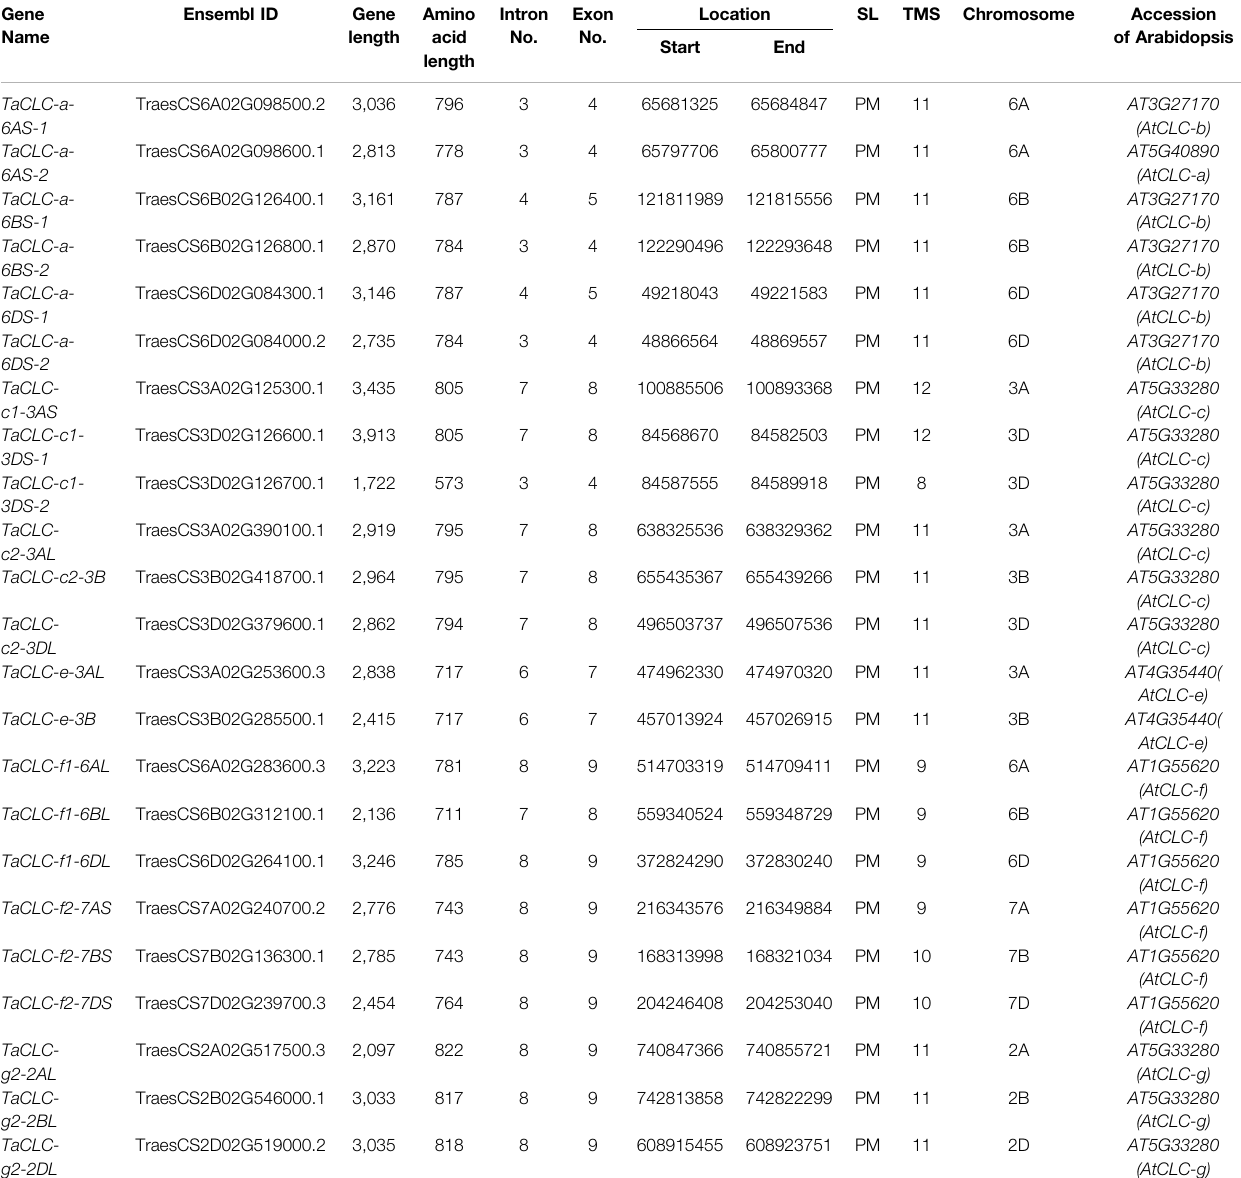
TABLE 1 | Main information of 23 wheat TaCLC